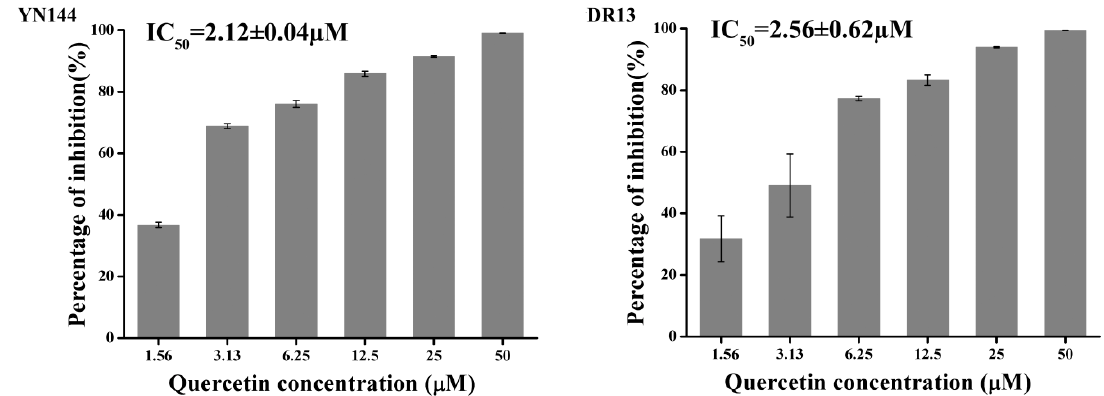
Figure 2. Antiviral activity of quercetin against the porcine epidemic diarrhea virus (PEDV) YN144 strain and DR13 strain in CCL-81 cells. CCL-81 cells grown on a 12-well plate were infected with the PEDV YN144 or DR13 strain at a multiplicity of infection (moi) of 0.001 in the presence of quercetin at different concentrations. Samples were collected at 24 hpi for the YN144 strain and 36 hpi for the DR13 strain and subjected to quantify the viral genome by quantitative real-time RT-PCR. The half maximal inhibitory concentration (IC 50 ) was calculated by probit regression using SPSS Statistics 17.0 software to assess the inhibition ratios at different inhibitor concentrations.